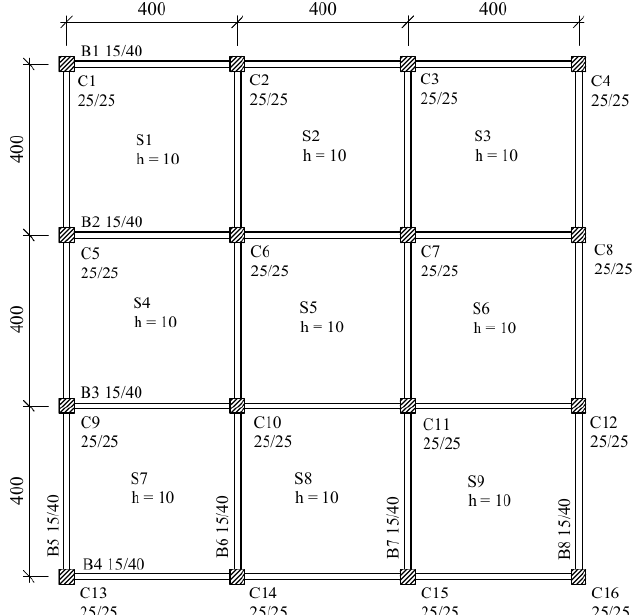
Figure 2. Designed floor plan, dimensions (in centimeters), and structural elements (not in